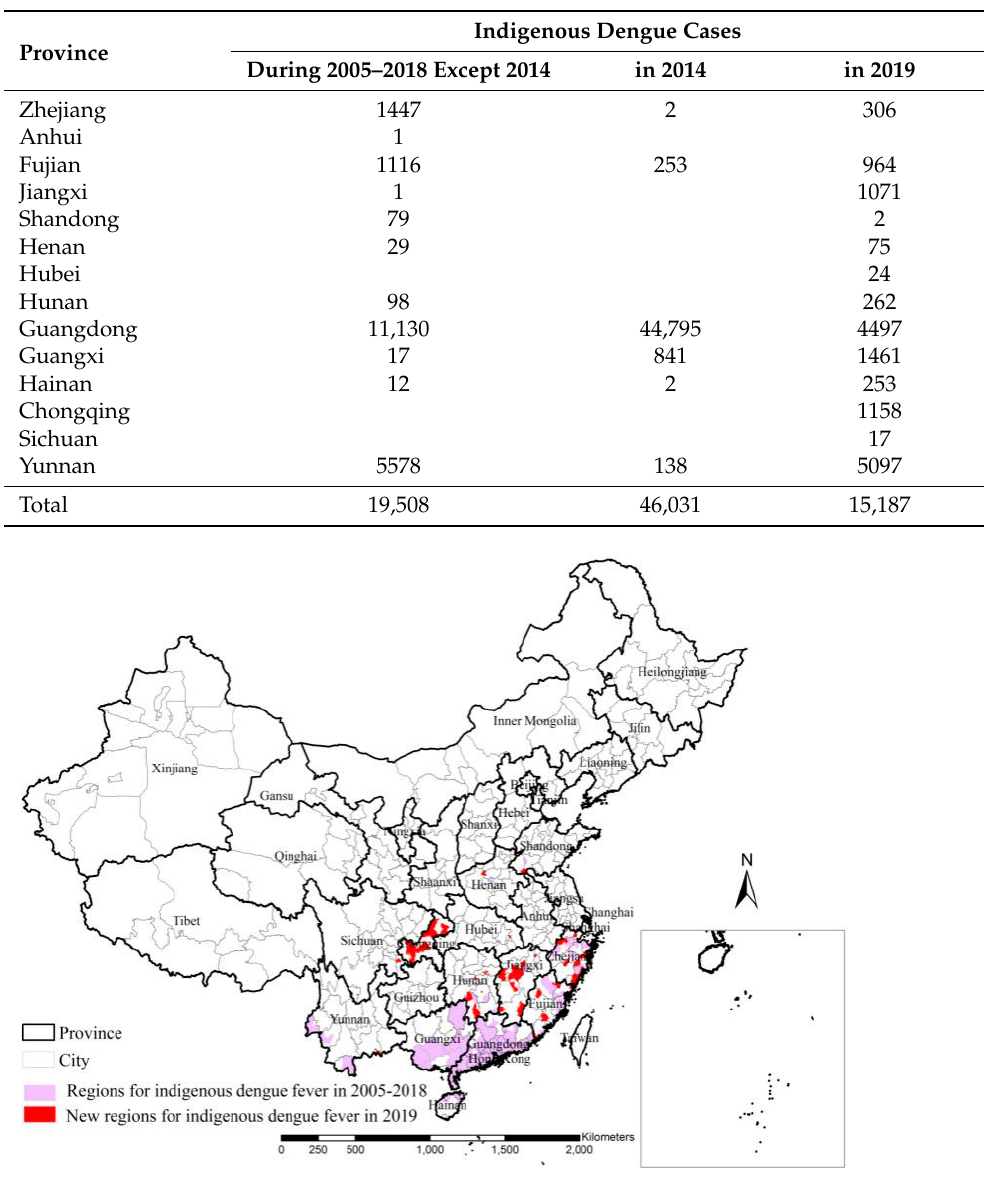
Figure 7. Comparative analysis of indigenous dengue fever cases between 2019 and 2005–2018. Imported dengue cases were from 66 countries located in Africa (26 countries), Asia (18 countries), North America (eight countries), South America (seven countries) and Ocea- nia (seven countries) during the period 2005–2019 (Figure 8) [22,24]. In 2019, there were five new sources of importation, namely Cuba, Guyana, Guinea, Ivory Coast and Mexico. There were 6654 overseas imported dengue cases during the period 2005–2018